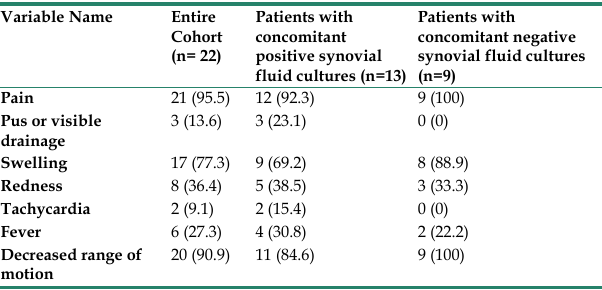
Table 2. Clinical Presentation of Patients with Prosthetic Joint